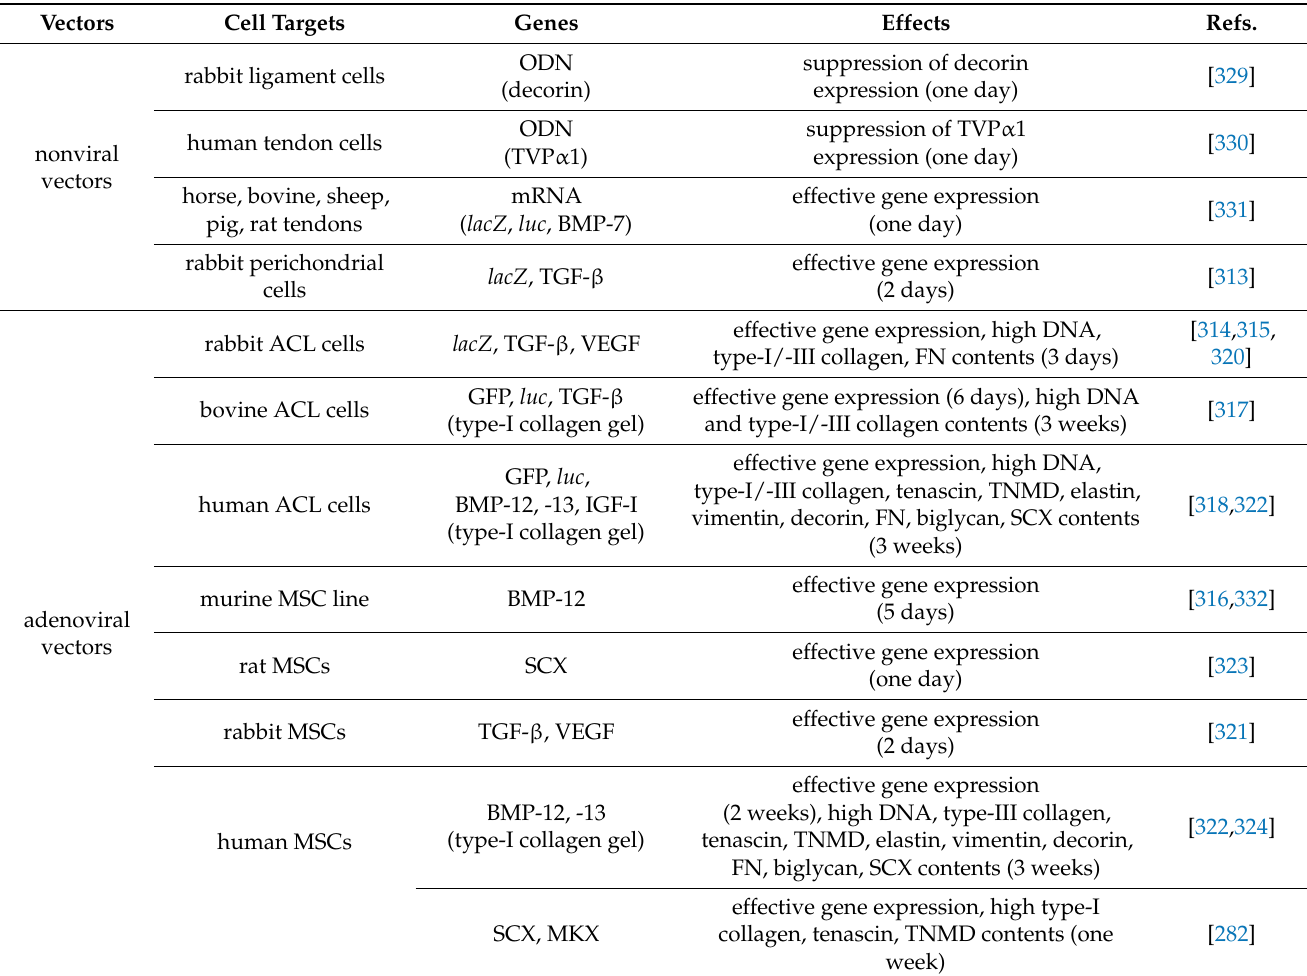
Table 3. Applications of classical gene therapy for ACL repair in vitro and in